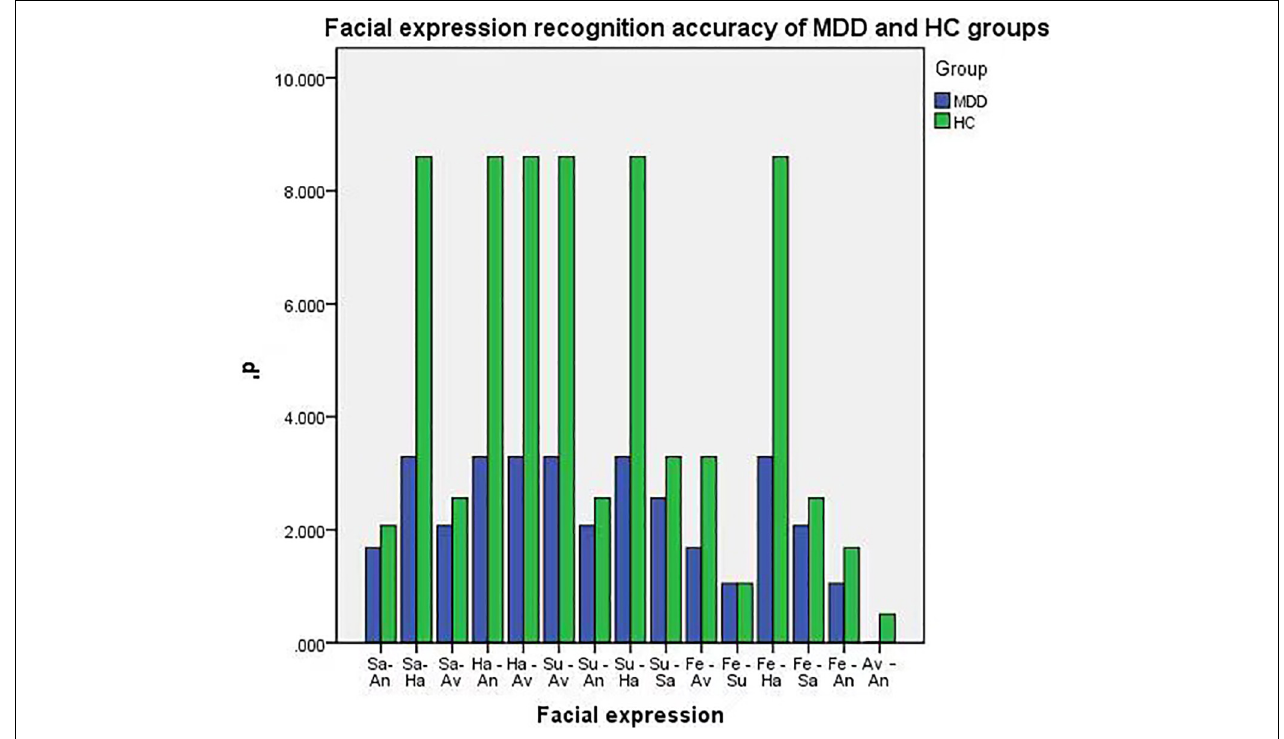
FIGURE 2 | Facial expression recognition accuracy of MDD and HC groups.